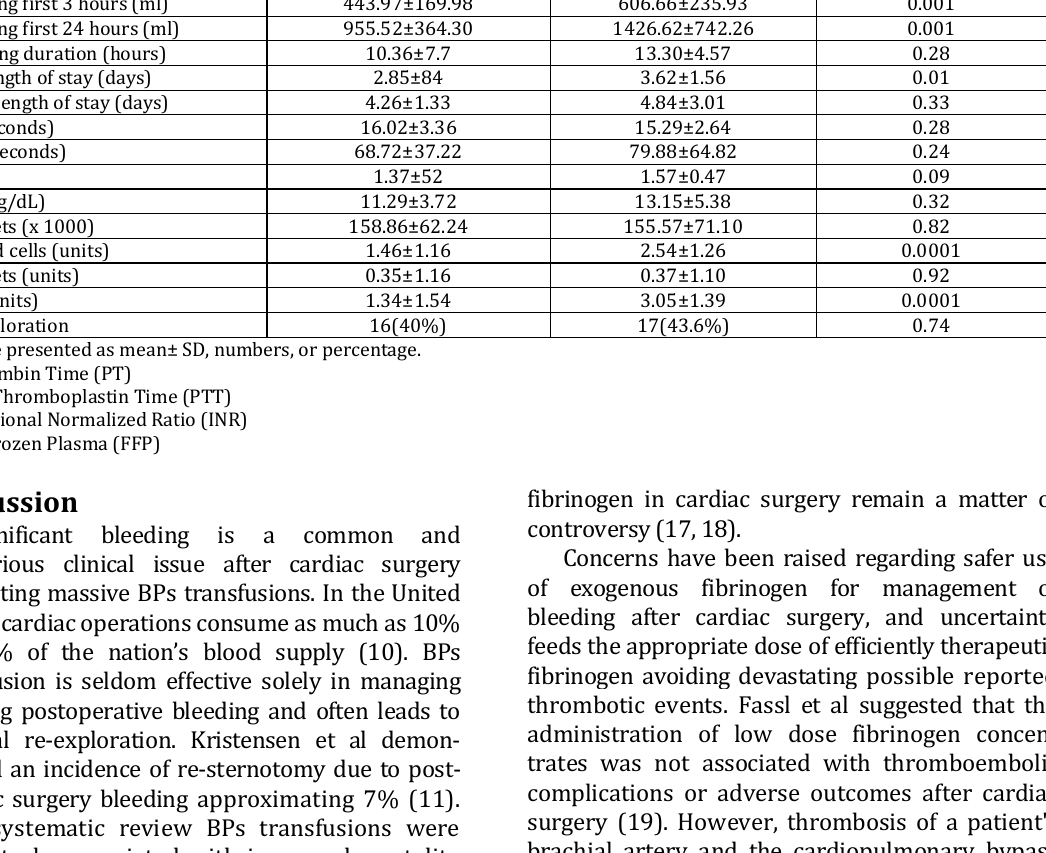
Table 3. Postoperative data of patients undergoing cardiac surgery in fibrinogen and control group